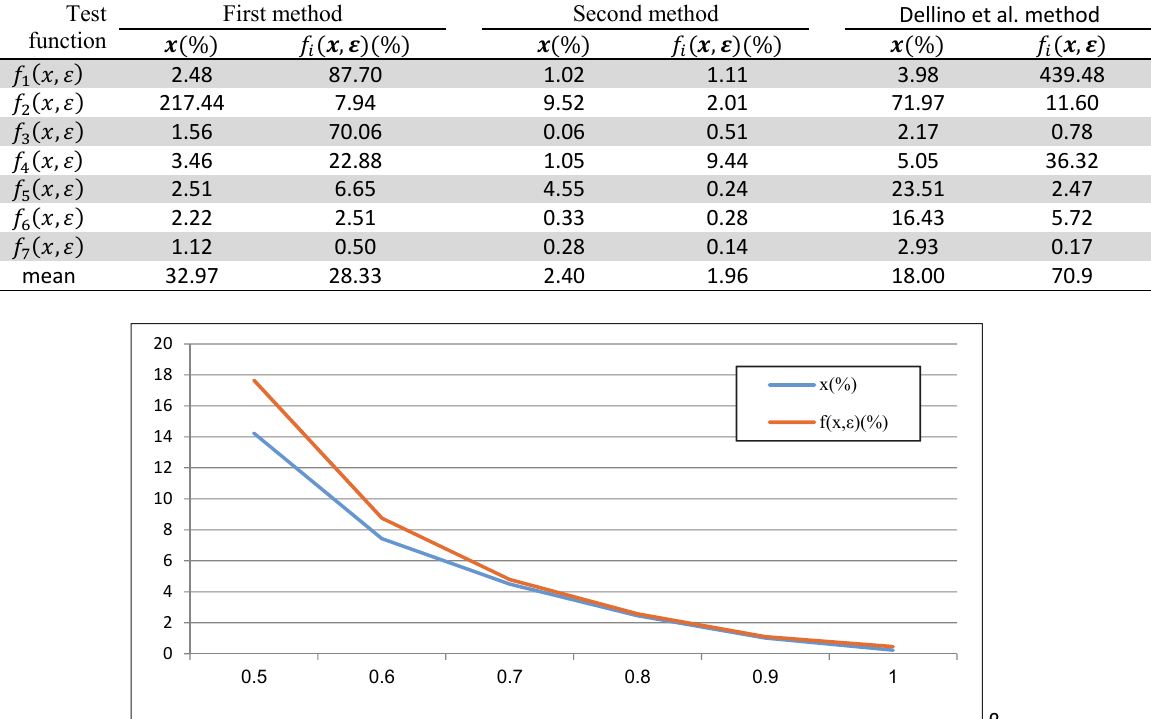
(cid:2188) (cid:4666)(cid:2206), (cid:2778)